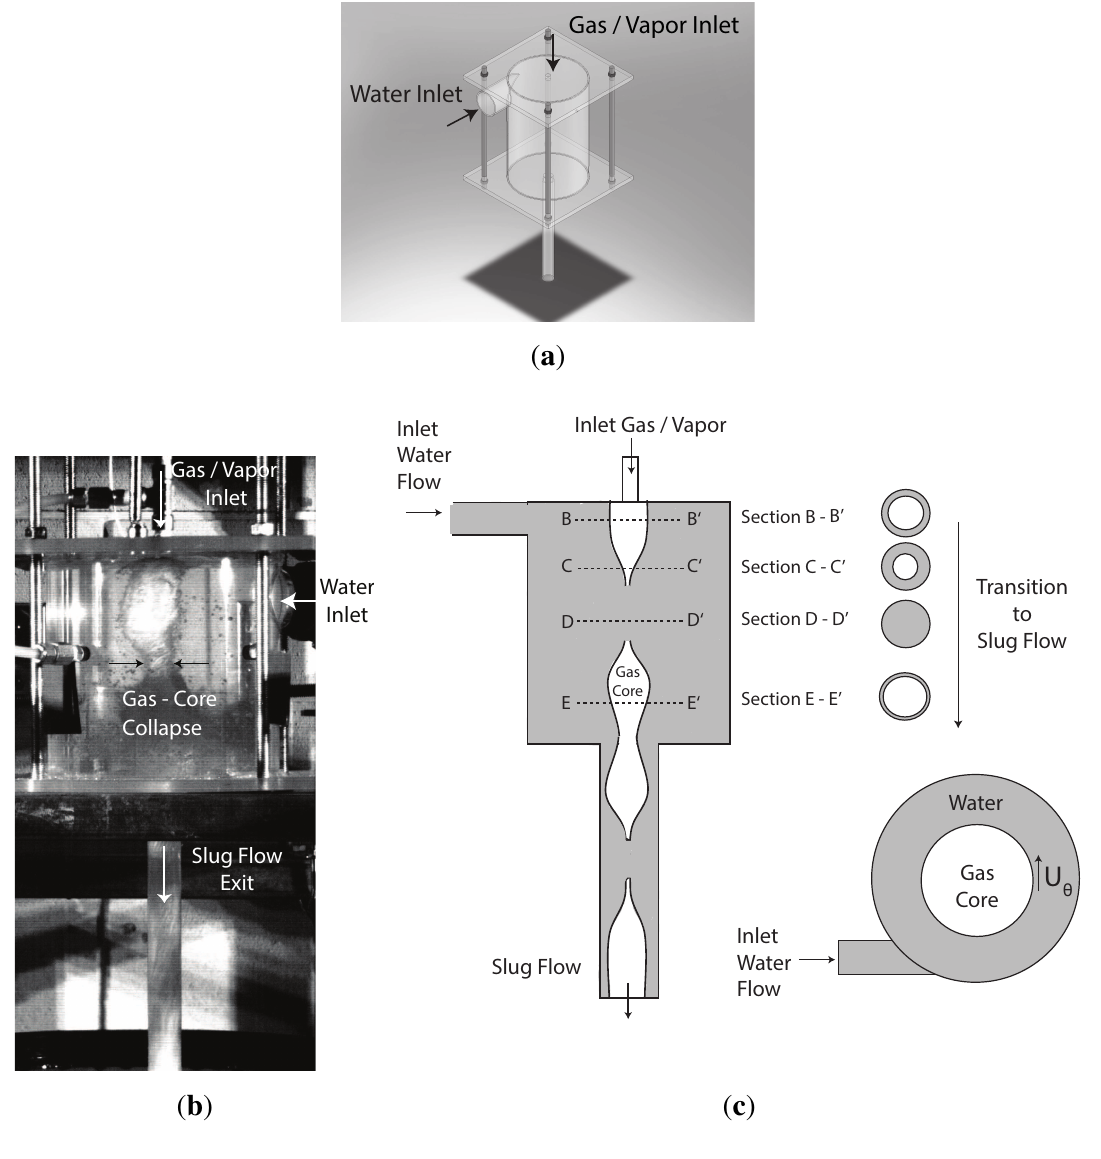
Figure 3. Vortex generation. ( a ) Geometry; ( b ) experiments; ( c )